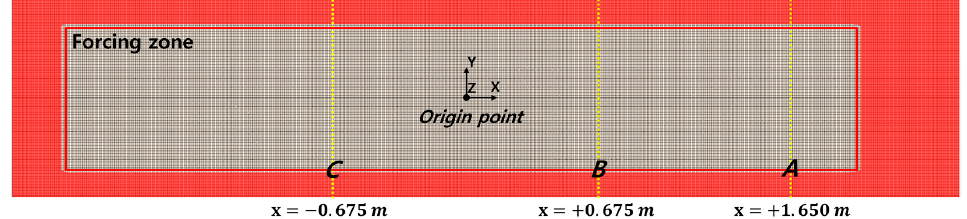
Figure 10. Computation domain in waves through grid sensitivity analysis.